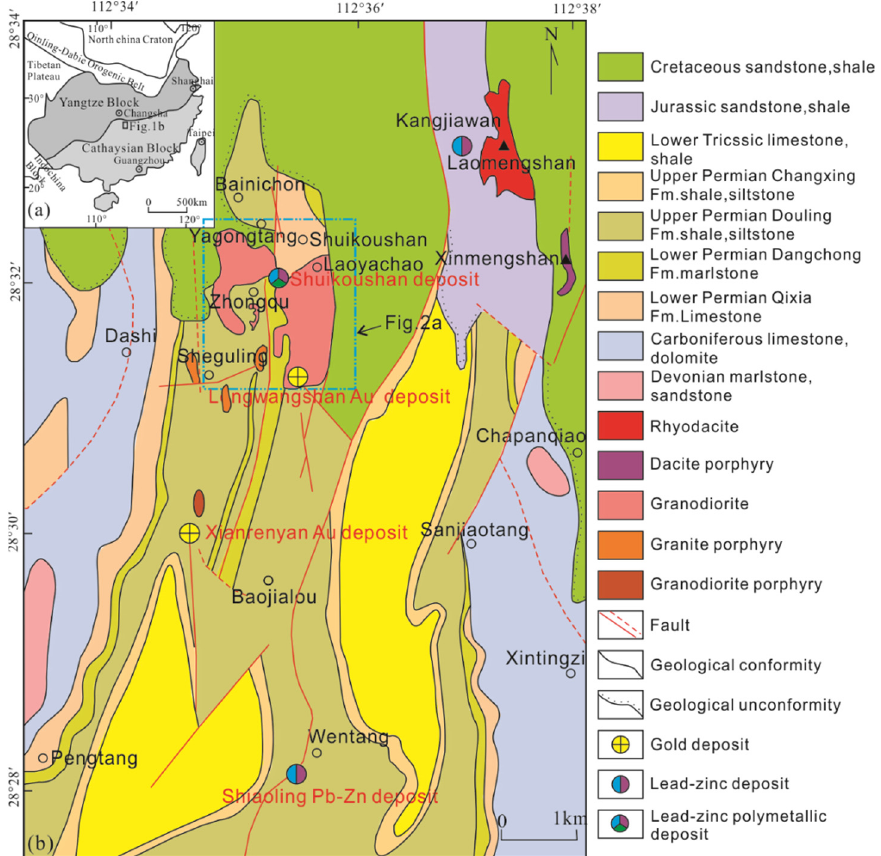
Figure 1. ( a ) The tectonic regimes of South China, the location of the Shuikoushan ore field is highlighted using a square. ( b ) Geologic map of the Shuikoushan ore field showing locations of various deposits (modified after [2,5]); the location of the Shuikoushan deposit is outlined using a blue dashed square.